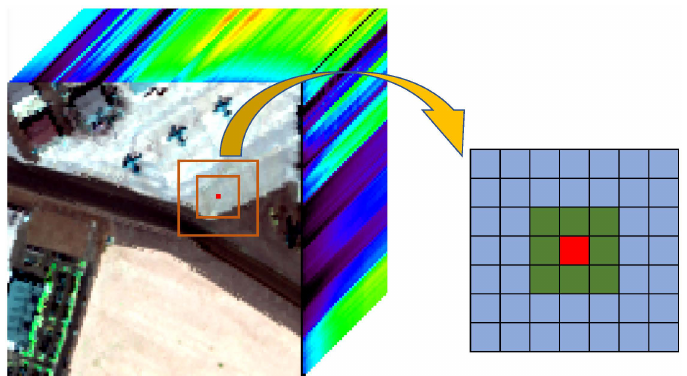
Figure 1. Description of the dual